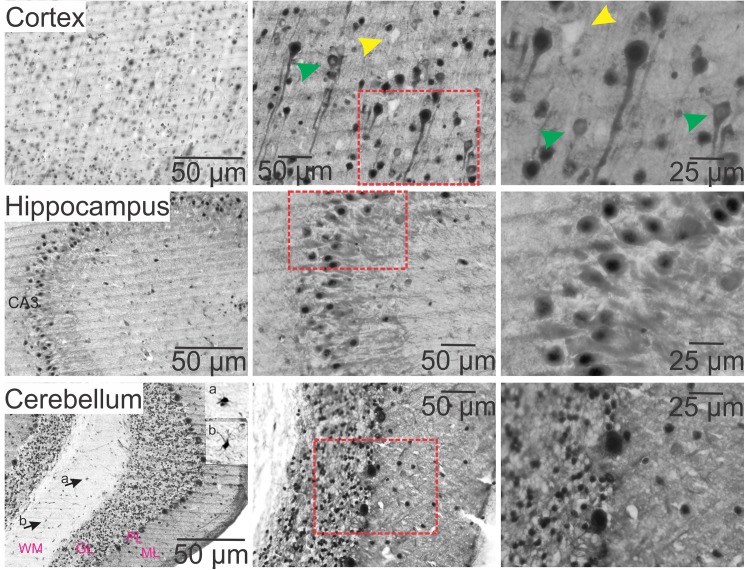
Characterization of cancer-IgGs binding against rat tissue in cortex, hippocampus, and cerebellum.The top panel shows a section from cortex stained with serum from a cancer patient. Autoreactive antibodies targeted cell plasma membrane, cell bodies, and axons/dendrites. The nucleus was not uniformly stained and a few scattered cells were devoid of nuclear staining (green arrowheads). A population of neurons was not stained at all (opaque area, yellow arrowheads). The middle panel shows a CA3 hippocampal region where, similar to the cortex, immunoreactivity was found in the nucleus and cell body. The bottom panel shows a cerebellar section where immunoreactivity was highest in the Purkinje and granular cell layers. However, some cells in the white matter (a & b, arrows point and insets) and molecular layer were also stained. Tissue sections were stained with Can-2 serum. WM, white matter; GL, granular layer; PL, Purkinje cell layer; ML, molecular layer.